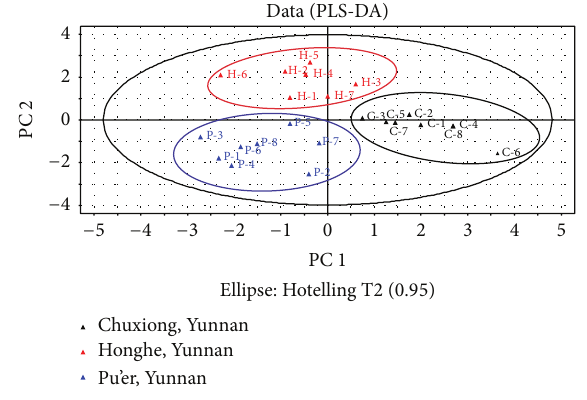
Figure 6: PLS-DA score plot based on UV spectra of W. extensa samples.